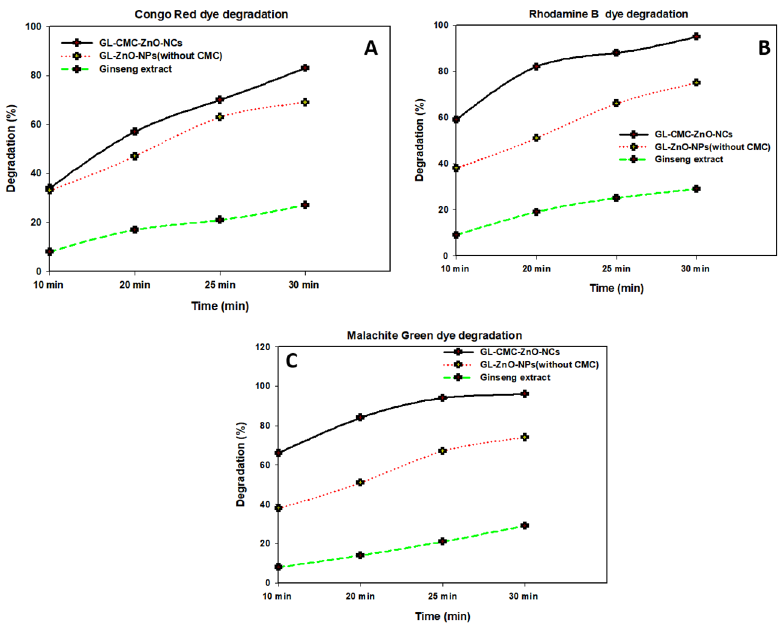
Figure 10. Different dye degradation rates with time using the GL–CMC–ZnO NCs: ( A ) CR dye degradation rates; ( B ) RB dye degradation rates; ( C ) MB dye degradation